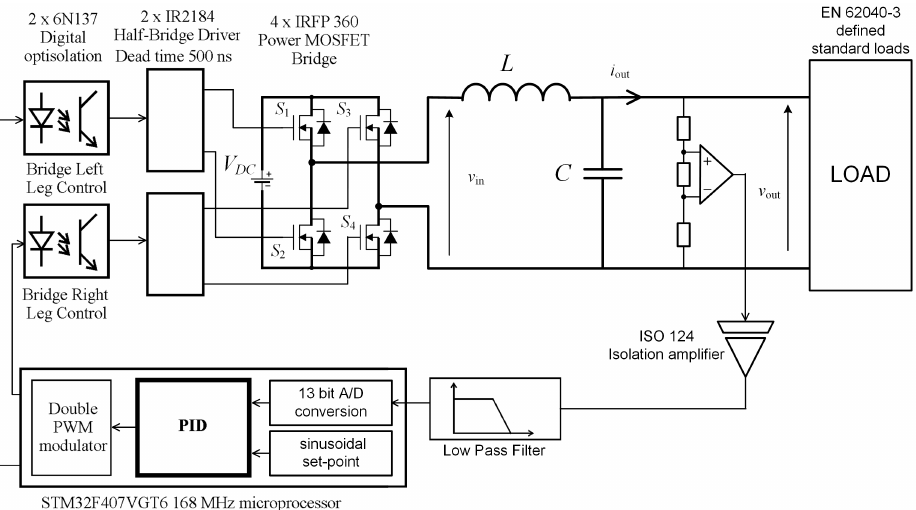
Figure 1. Schematic of the experimental rig. LC filter components: a torroidal core coil with nominal inductance L F = 1 mH made of alloy-powder Super-MSS material and MKP type metallized polypropylene capacitor with nominal capacitance C F = 50 µ F. Further details and photo can be found in [14].